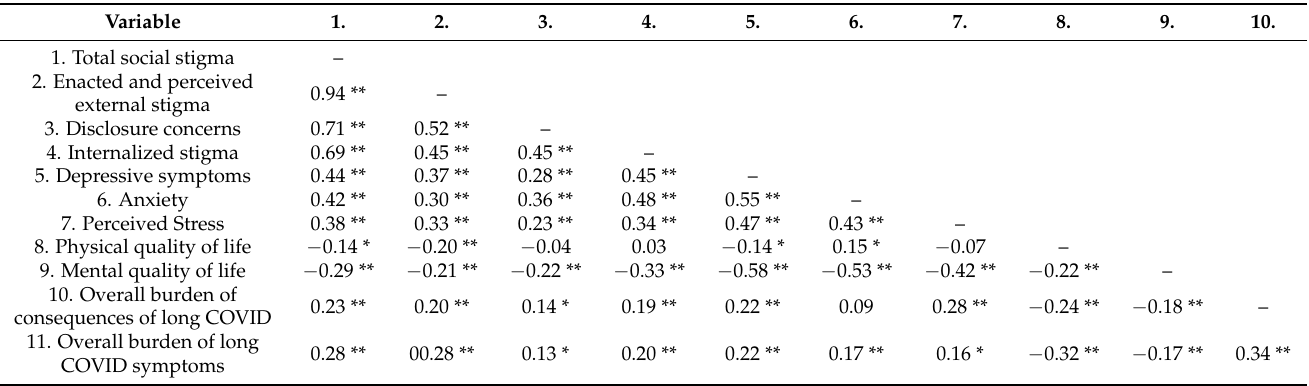
Table 2. Correlations between total social stigma score, social stigma subscales, outcome measures, and overall burdens of consequences and